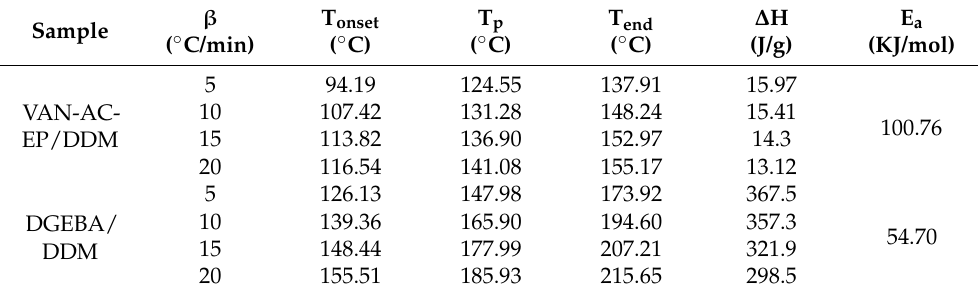
Table 1. Curing process data of VAN-AC-EP/DDM and DGEBA/DDM.